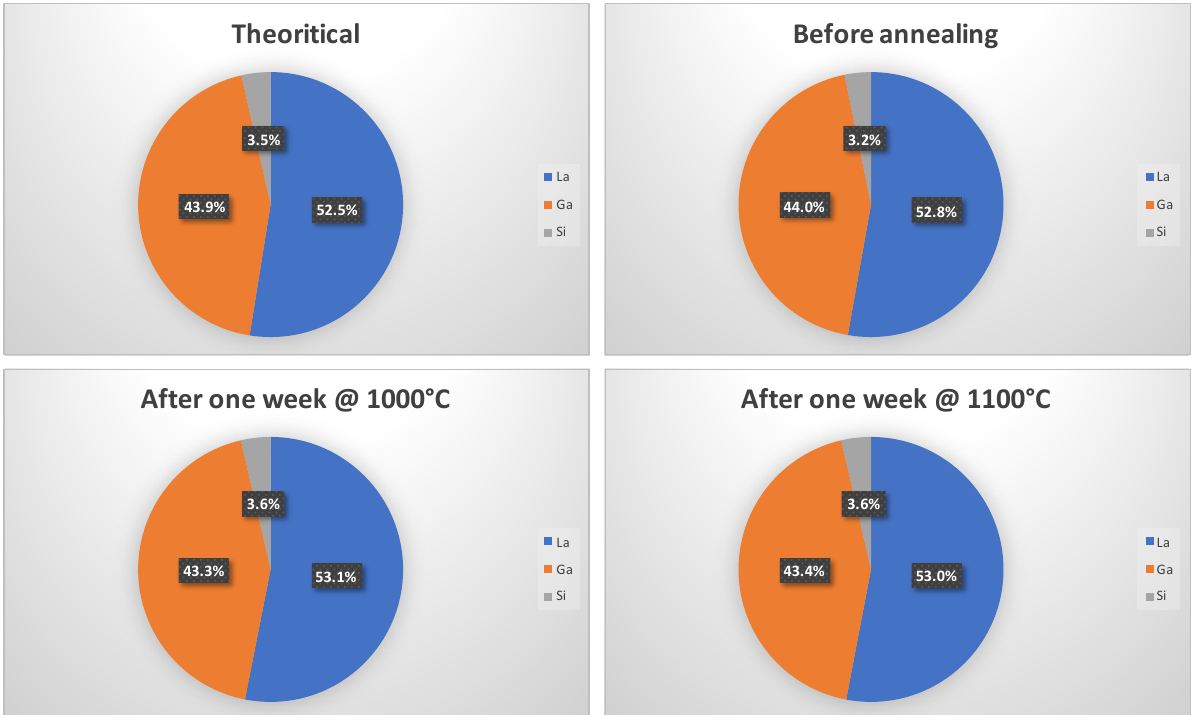
Figure 2. EDXS chemical composition (mass percentage) of reference and annealed LGS crystal surface.